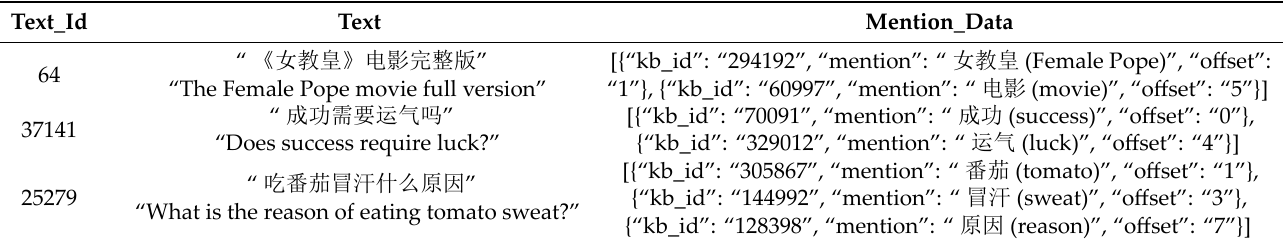
Table 2. Experimental annotation data examples.